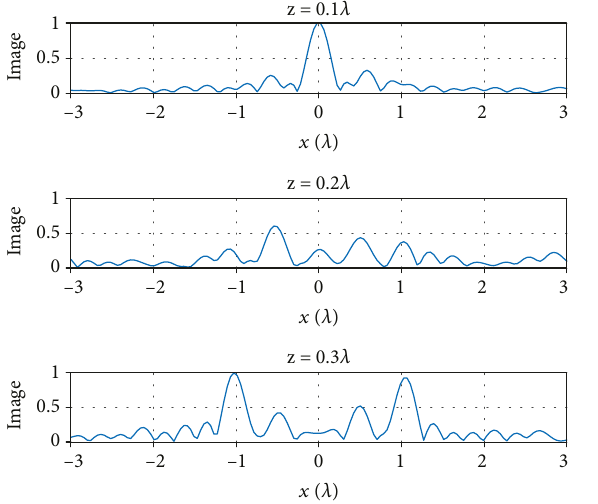
Figure 13: Reconstructed images when using 13 resonant dipole =0.1 λ , z =0.2 λ , antennas. For this example, the parameters are z 1 2 z =1.5 λ , d = λ , d =2 λ , s = λ /8, and D =0.25 λ . These results are 3 2 3 with SNR =15dB.